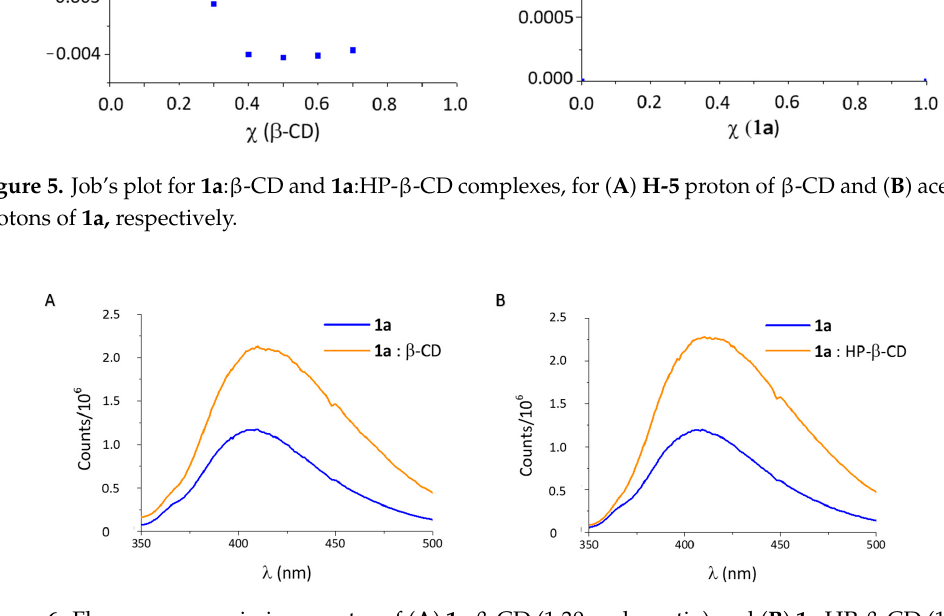
Figure 6. Fluorescence emission spectra of ( A ) 1a : β -CD (1:30 molar ratio) and ( B ) 1a :HP- β -CD (1:50 molar ratio). 1a concentration is 2.2 × 10 − 4 M.